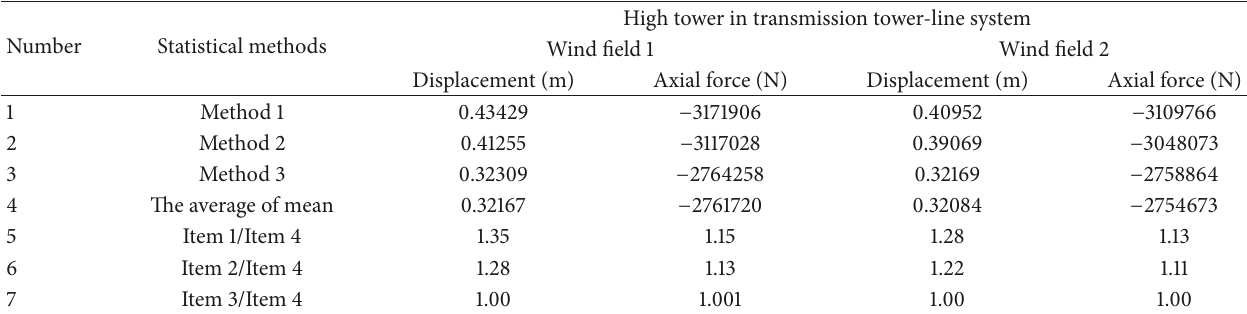
Table 24: Comparison of statistical results on high tower in the system node 35# Ux displacement and element 1972# axial force.